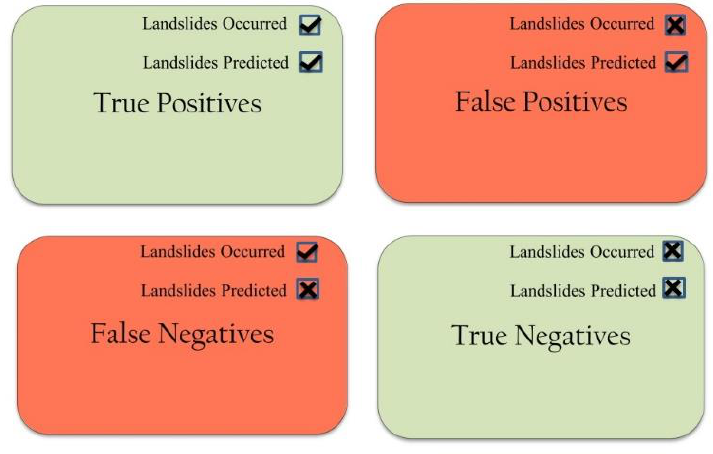
Figure 7. Confusion matrix for quantitative comparison.